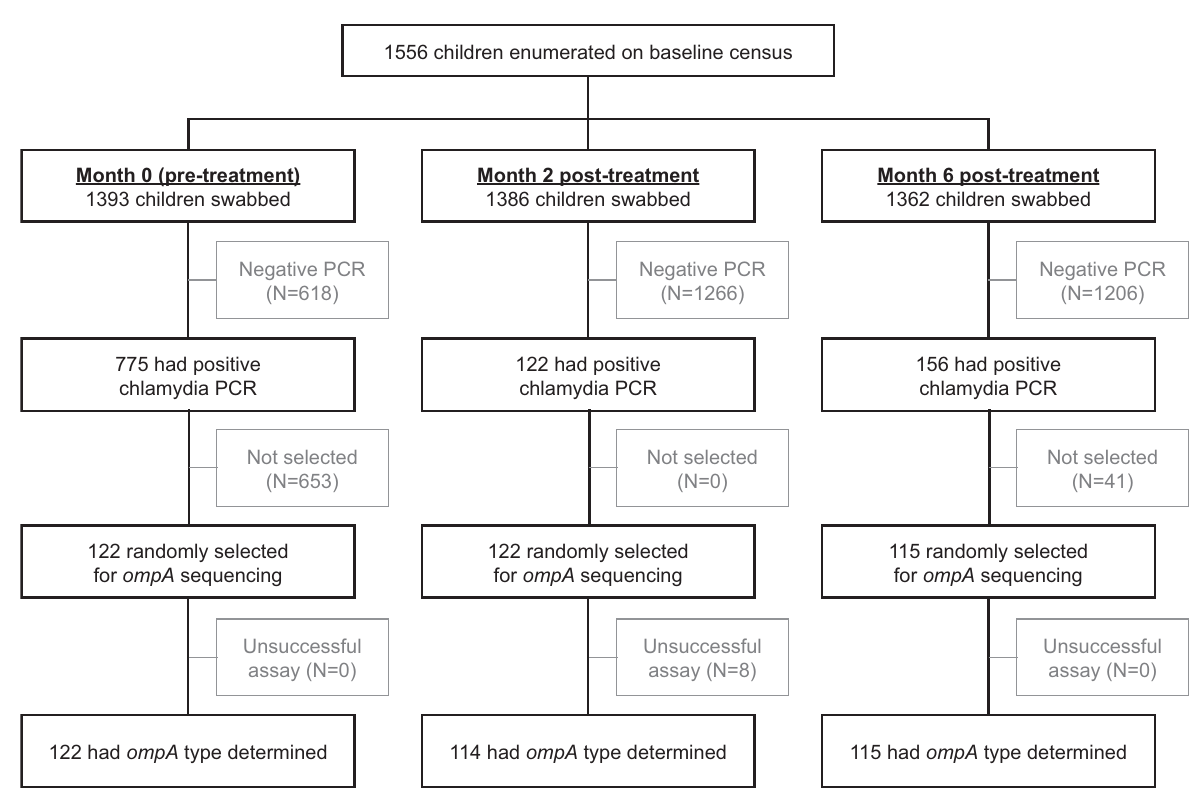
Fig 2. Flow diagram. Participant flow is shown separately for baseline (i.e., pre-treatment), month 2, and month 6.